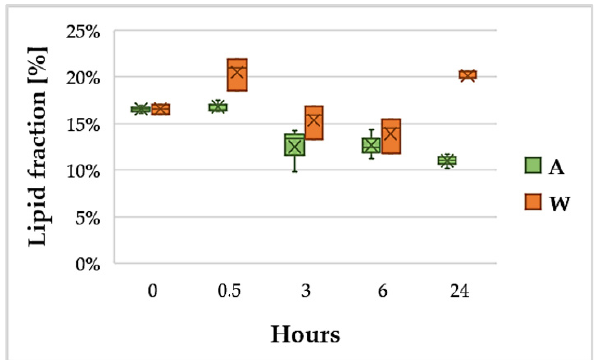
Figure 5. Variation of the lipid content in the biomass grown in wastewater (W) or Allen medium (A). The 8 h of darkness in the climatic chamber occur between 6 h and 24